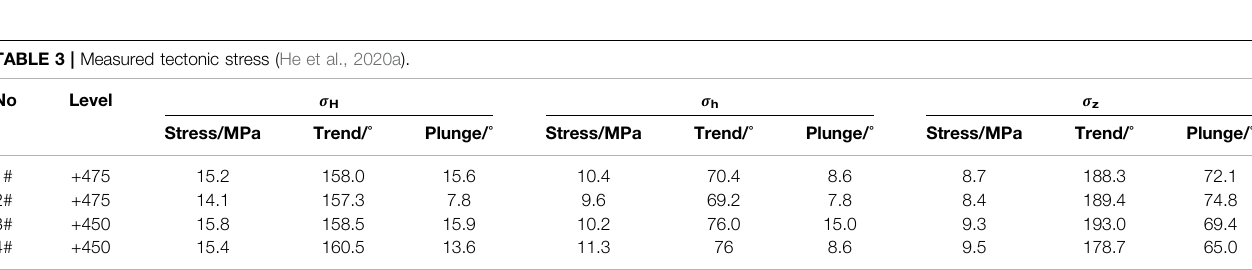
TABLE 3 | Measured tectonic stress (He et al.,